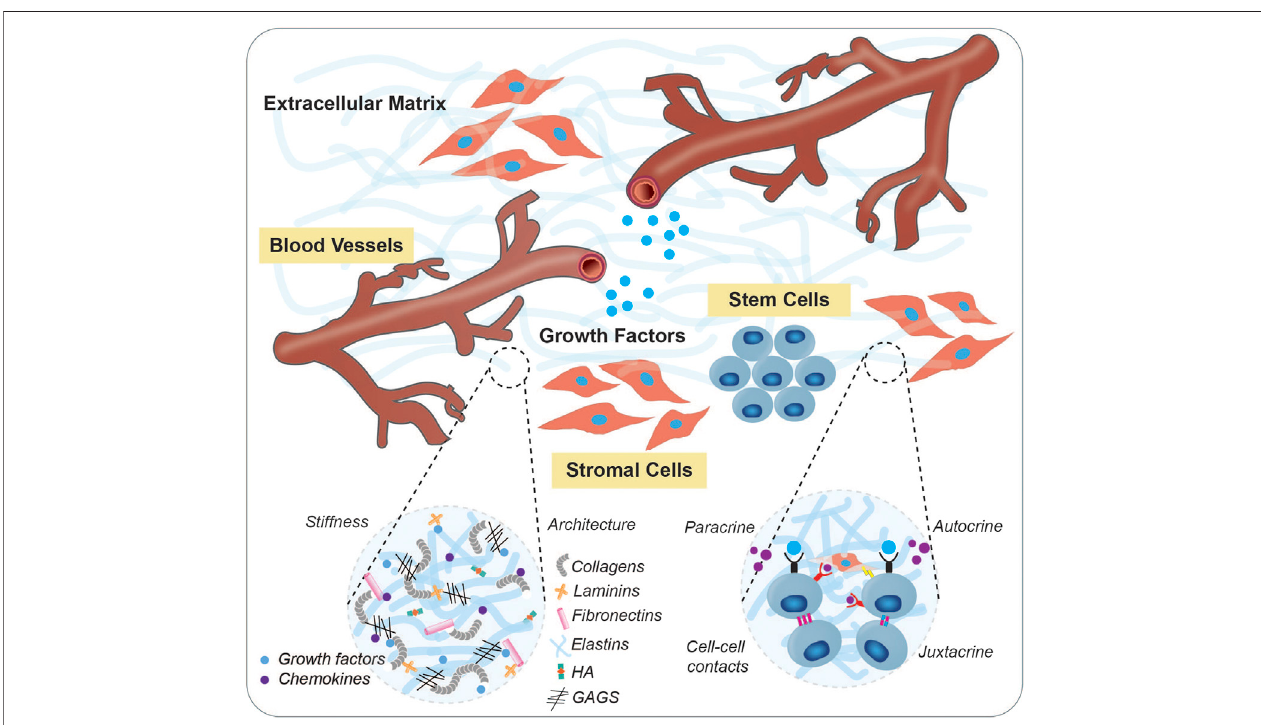
FIGURE 1 | The stem cell niche. Stem cells require specialized microenvironments that facilitate their maintenance and functions via structural support, dynamic signaling mechanisms, trophic networks, topographical information, and physiological cues. Shown is a schematic of a typical stem cell niche which includes humoral cue delivering-vascular networks, supporting stroma, extracellular matrix, and soluble factors. Insets depict speci fi c components of the ECM, as well as interactions between neighboring cells.